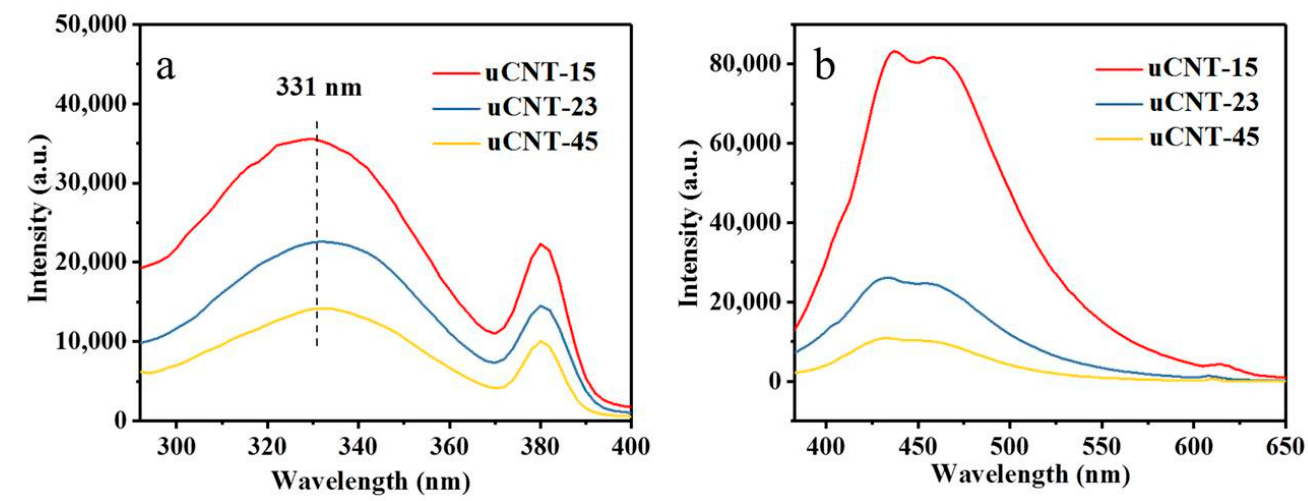
Figure 8. Excitation ( a ) and emission ( b ) spectra of uCNTs.